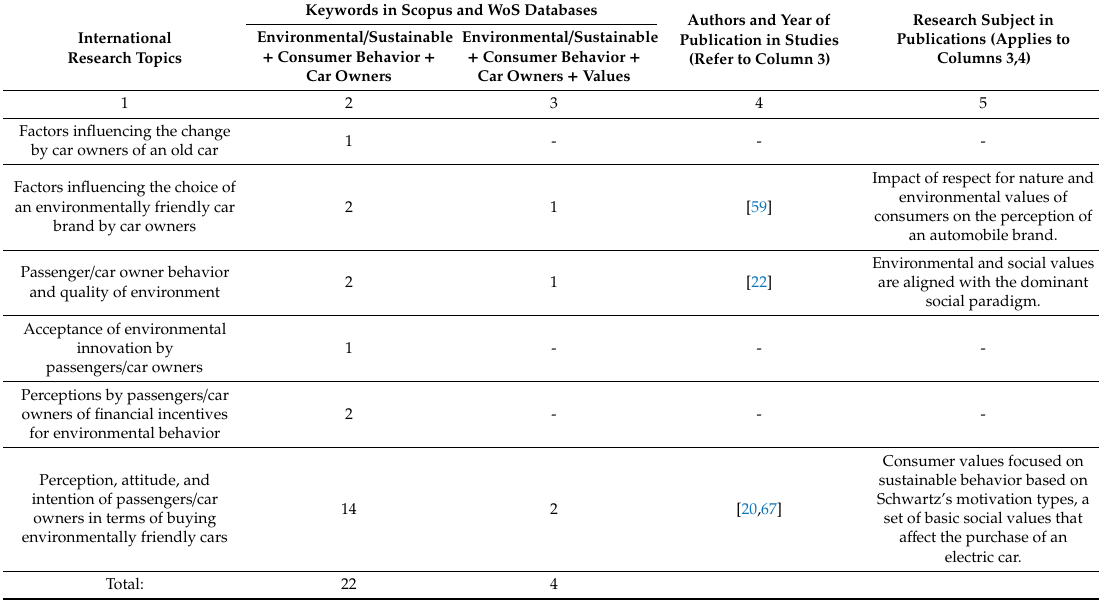
Table 2. Papers on research of environmental behavior of car owners based on the study of their values.